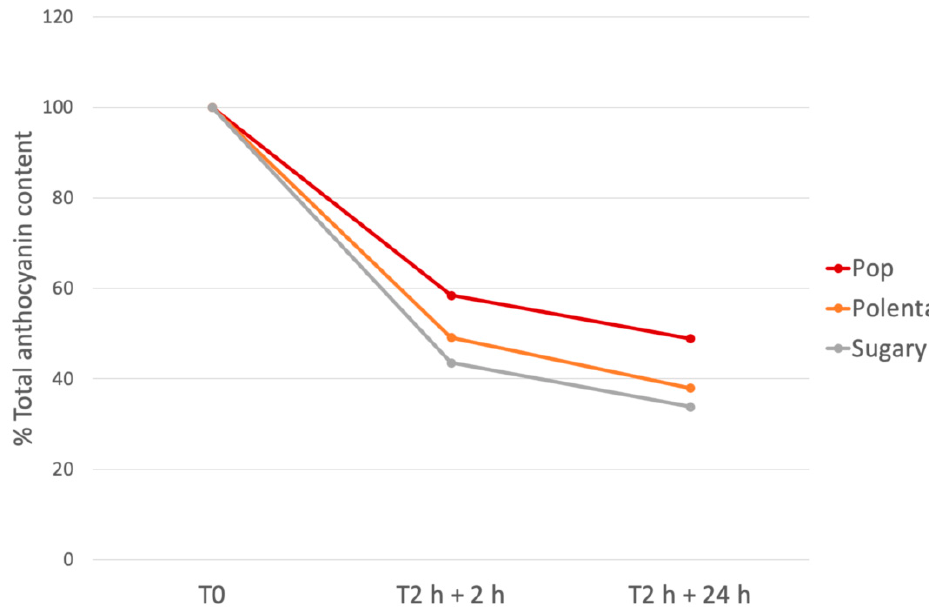
Figure 7. Reduction trend (in percentage) of total anthocyanin content during the gastro-intestinal